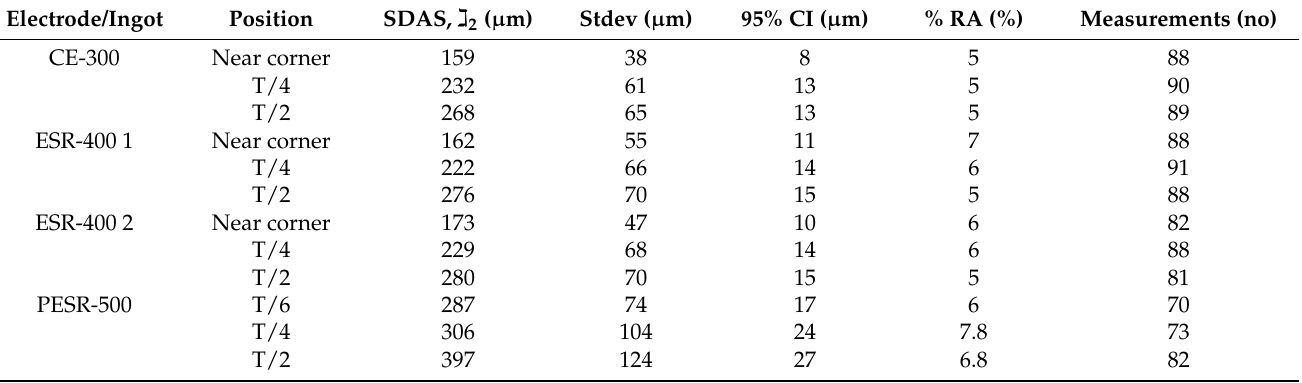
Figure 6. Secondary dendrite arm spacing, (SDAS, ג 2 ), ( µ m), for electrode 300 × 300 mm 2 (C-300), electro-slag remelted 400 × 400 mm 2 (ESR-400), and electro-slag remelted under pressure-controlled atmosphere pressure electro-slag remelted ingots 500–1050 mm in diameter (PESR-500, -800, and-1050). Cross-section positions: T/6—quarter radius, T/4—half radius, and T/2—center. Table 3. Data and statistics for the secondary arm spacing, (SDAS, ג 2 ), measurements for electrode 300 × 300 mm 2 (CE-300), the electro-slag remelted ingots 400 × 400 mm 2 (ESR-400 1,2), and the pressure electro-slag remelted ingots 500–1050 mm in diameter (PESR-500, PESR-800, and